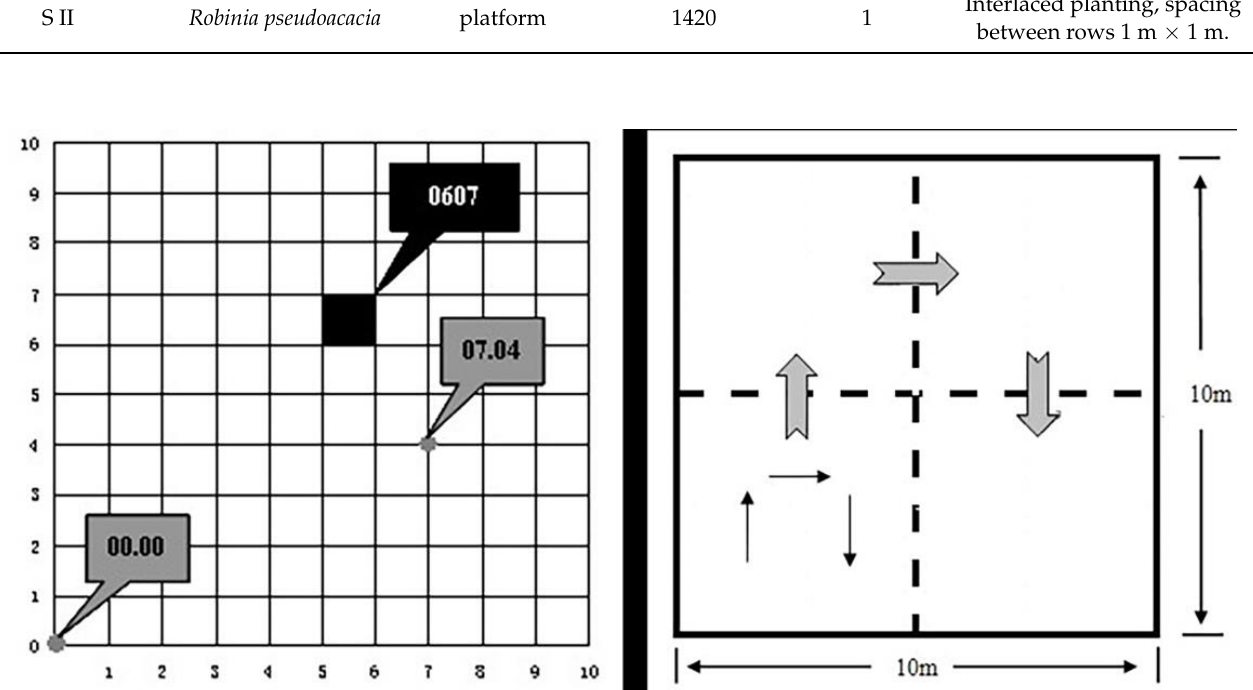
Figure 3. Sample plot division and work sequence diagram. Note: The picture on the left is a schematic diagram of the sample number, 0 is the origin, each small square is 10 m × 10 m, and the total is 100 m × 100 m. The picture on the right is a schematic diagram of the working sequence of each 10 m × 10 m sample.